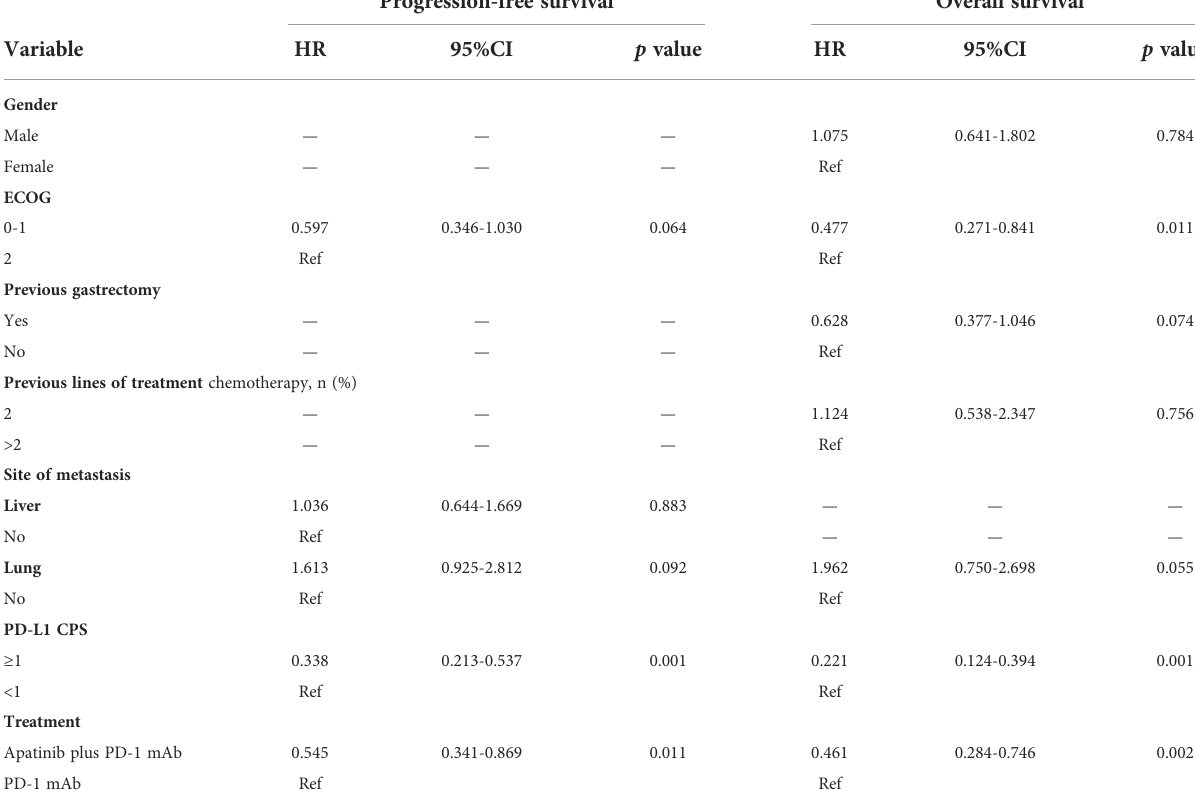
TABLE 4 Multivariate analyses of progression-free survival and overall survival for apatinib plus PD-1 mAb versus PD-1 mAb